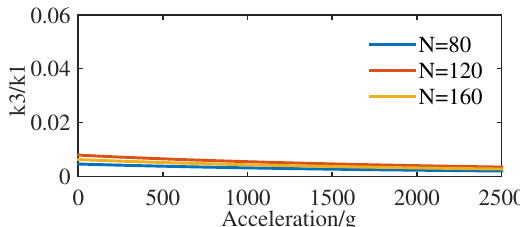
Figure 3. k 3 / k 1 curves with the measured acceleration and the pairs of comb